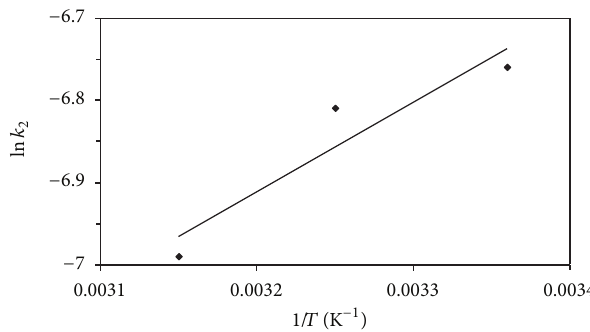
Figure 6: Plot of ln 𝑘 2 versus 1/𝑇 for estimation of activation energy for the adsorption of lead (II) ions onto the activated carbon (SAC2).